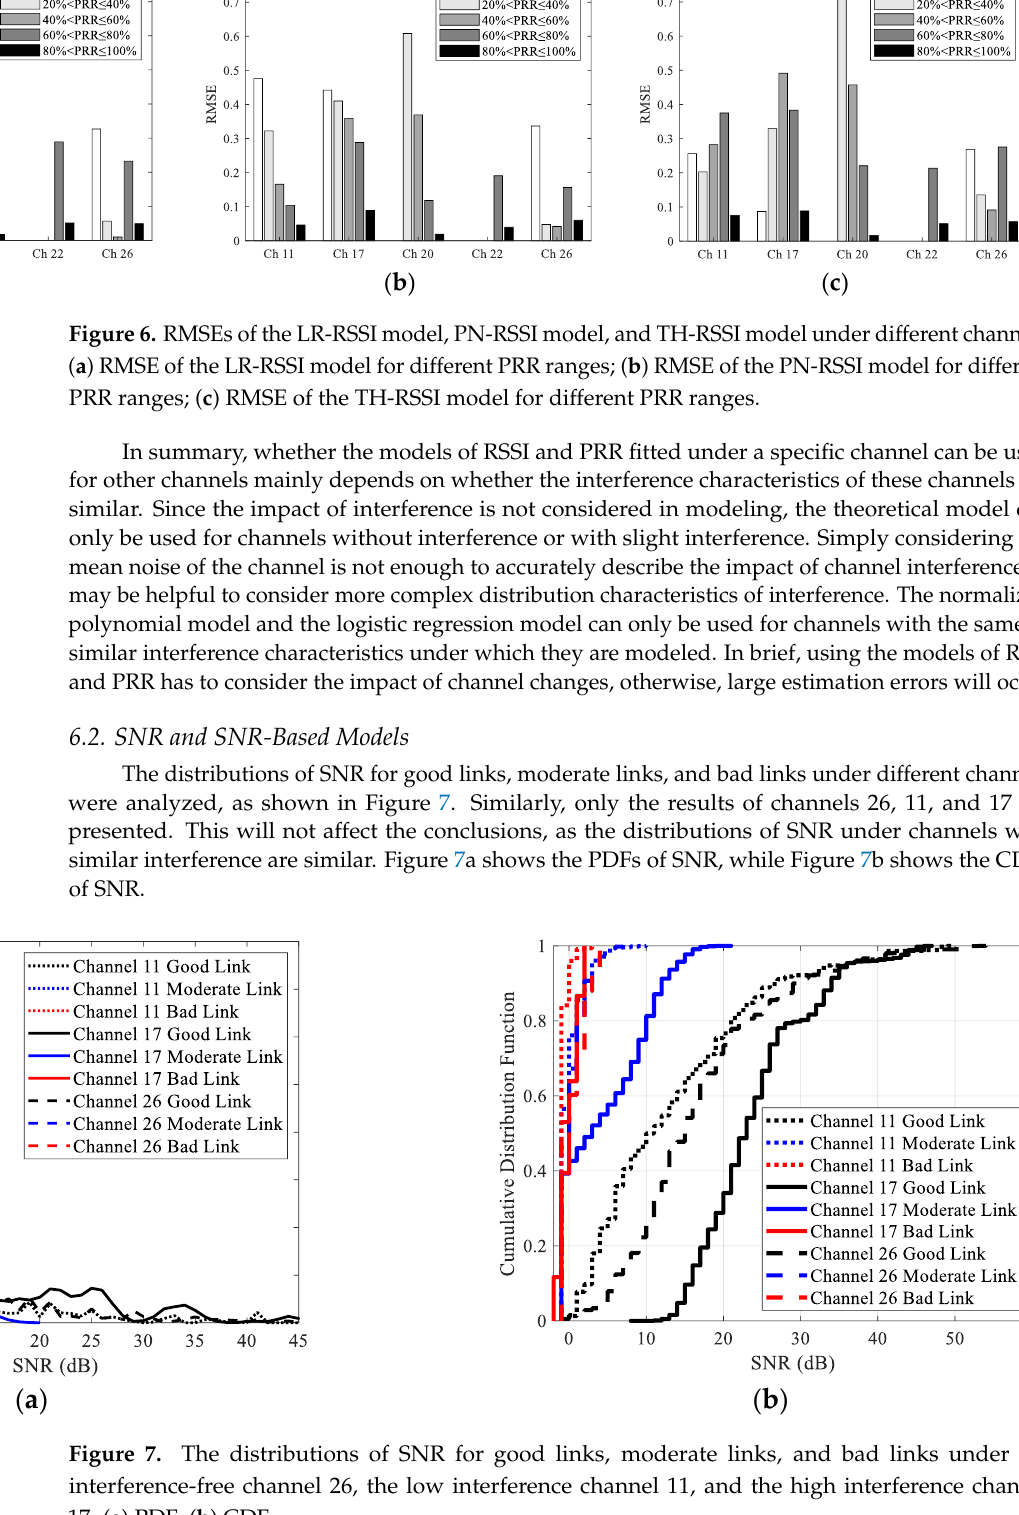
Figure 6. RMSEs of the LR-RSSI model, PN-RSSI model, and TH-RSSI model under different channels: ( a ) RMSE of the LR-RSSI model for different PRR ranges; ( b ) RMSE of the PN-RSSI model for different PRR ranges; ( c ) RMSE of the TH-RSSI model for different PRR ranges.